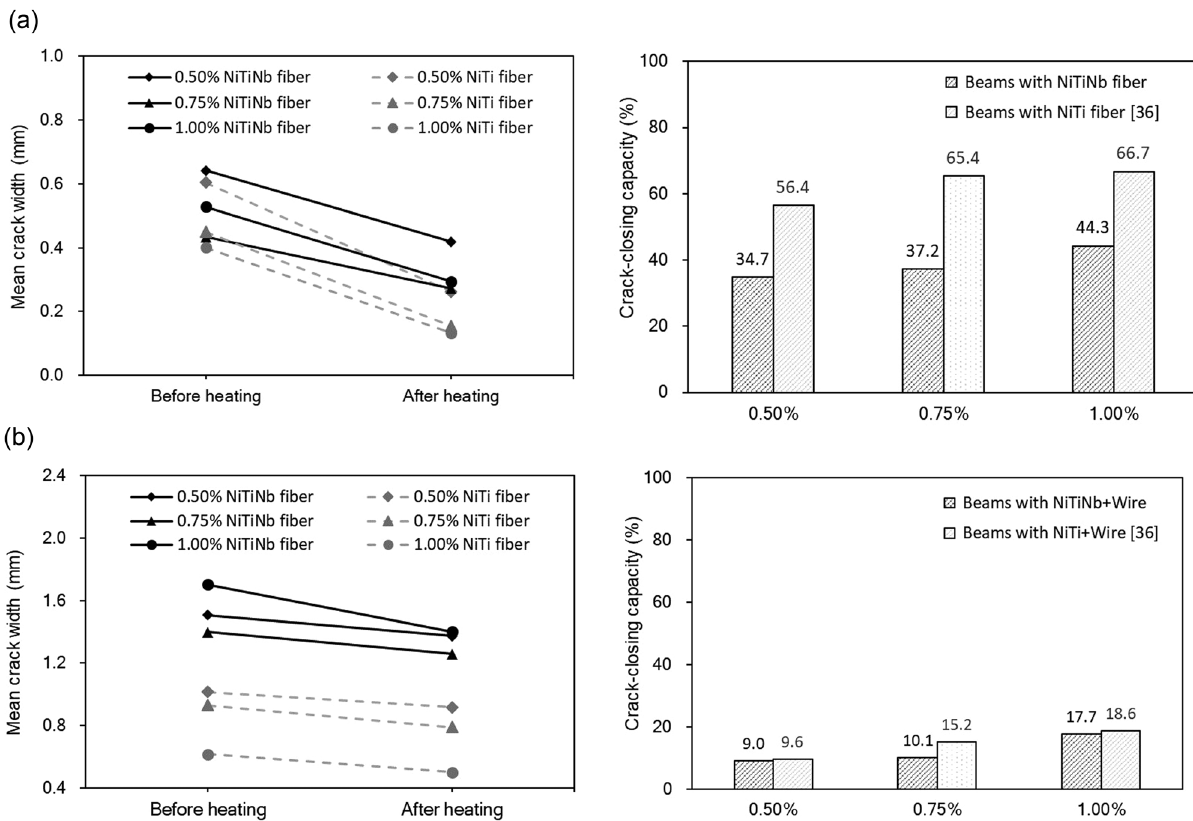
Figure 11: Crack closure from the SME in the SMA fi bers with fi ber volume fractions: ( a ) beam specimens without tensile wires and ( b ) beam specimens with tensile